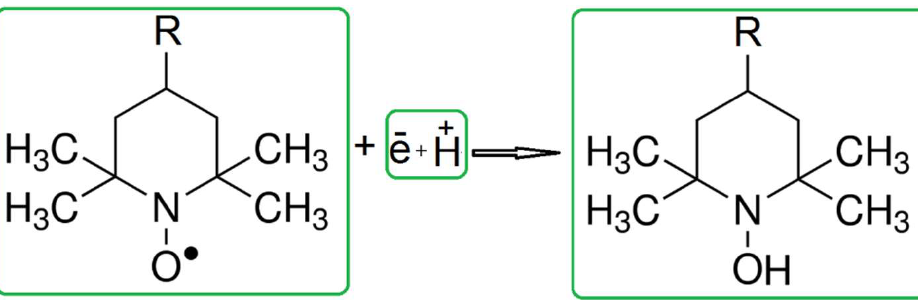
Figure 8. The schematic representation of TEMPO (R: -H) and TEMPOL (R: -OH) reduction to stable hydroxylamines.